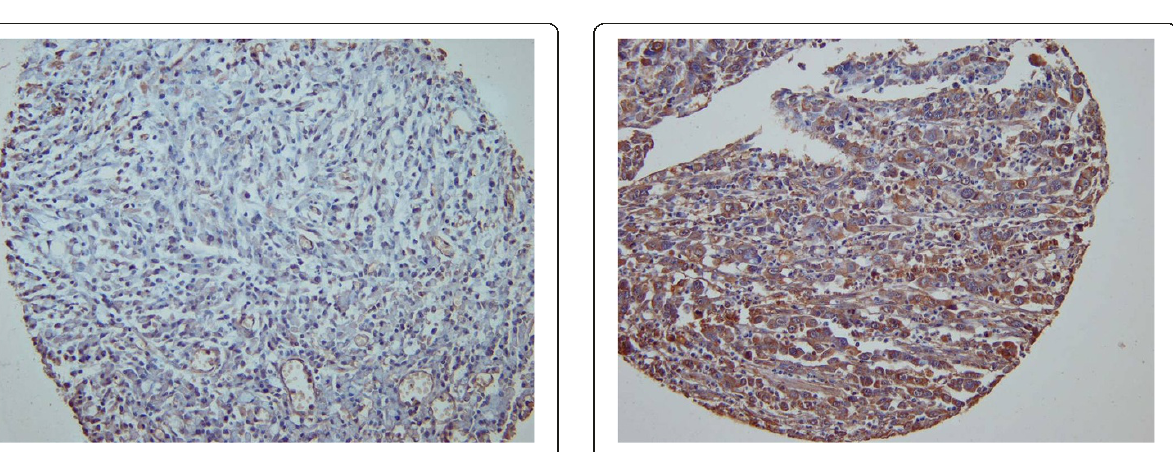
Figure 3 Immunohistochemical staining using c-MET antibody showing strong (+3) and diffuse cytoplasmic reaction in gastric cancer cells (c-MET,